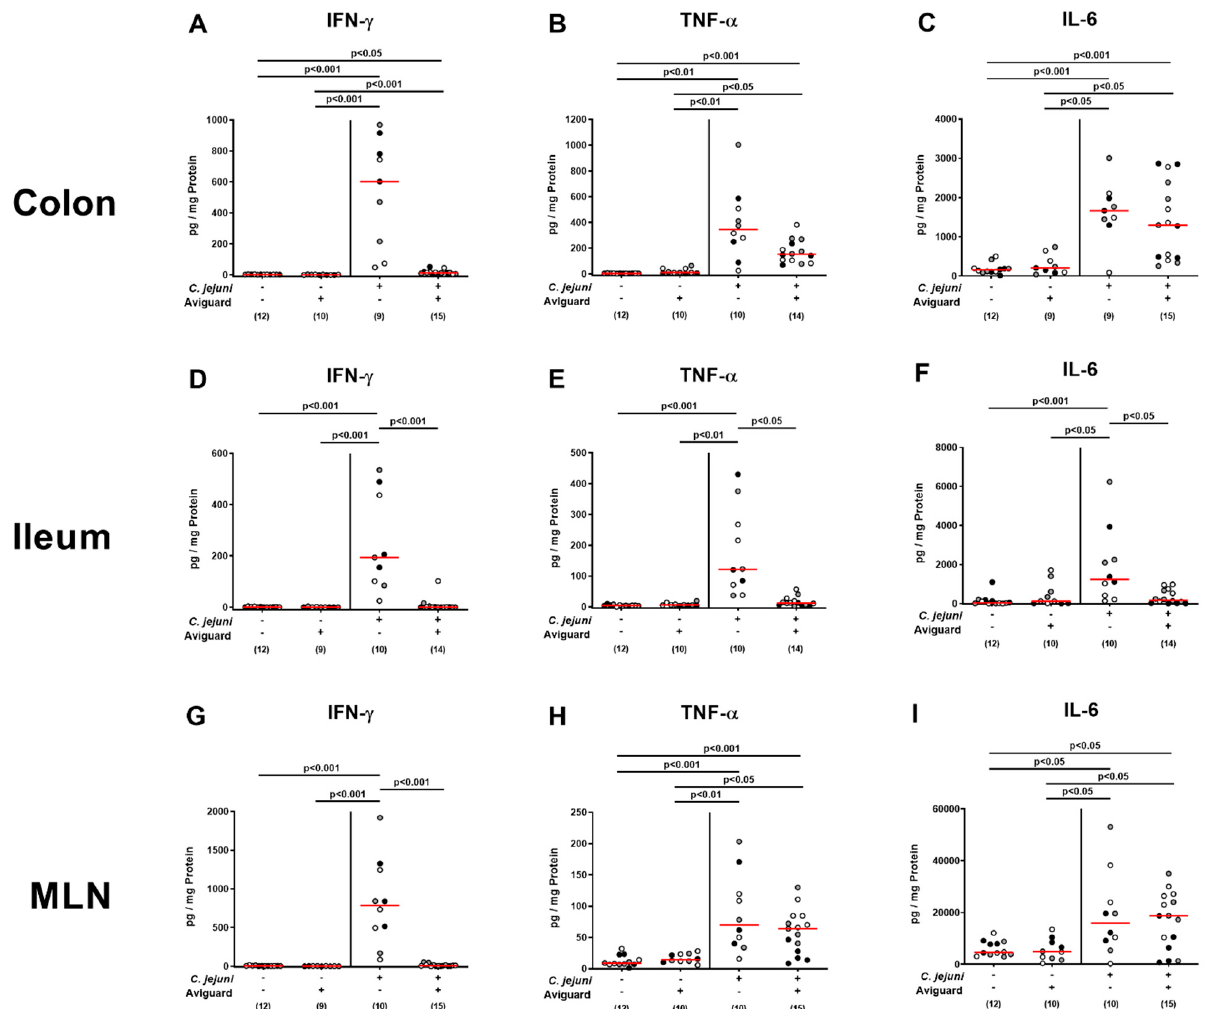
Figure 6. Aviguard ® treatment and pro-inflammatory cytokine secretion in the intestinal tract of C. jejuni -infected microbiota-depleted IL-10 − / − mice. Following C. jejuni strain 81-176 infection on days 0 and 1, microbiota-depleted IL-10 − / − mice were perorally treated with Aviguard ® or placebo on days 2, 3, and 4. On day 6 post-infection, ( A , D , G ) IFN- γ , ( B , E , H ) TNF- α , and ( C , F , I ) IL-6 concentrations were measured in ex vivo biopsies derived from the ( A – C ) colon, ( D – F ) ileum, and ( G – I ) mesenteric lymph nodes (MLNs). Medians (red bars), significance levels ( p values) calculated by the Kruskal–Wallis test and Dunn’s post-correction, and numbers of analyzed mice (in parentheses) are indicated. Data were pooled from three independent experiments (as indicated by black, white, and gray circles). Definite outliers were removed after identification using the Grubb’s test ( α = 0.001).